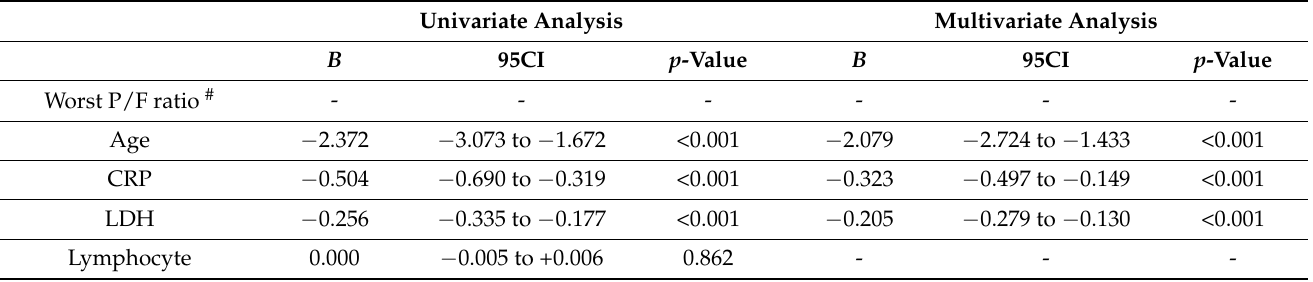
Table 3. Univariate and multivariate linear regression analysis between the worst P/F ratio during hospitalization (dependent), age, and laboratory parameters at admission.